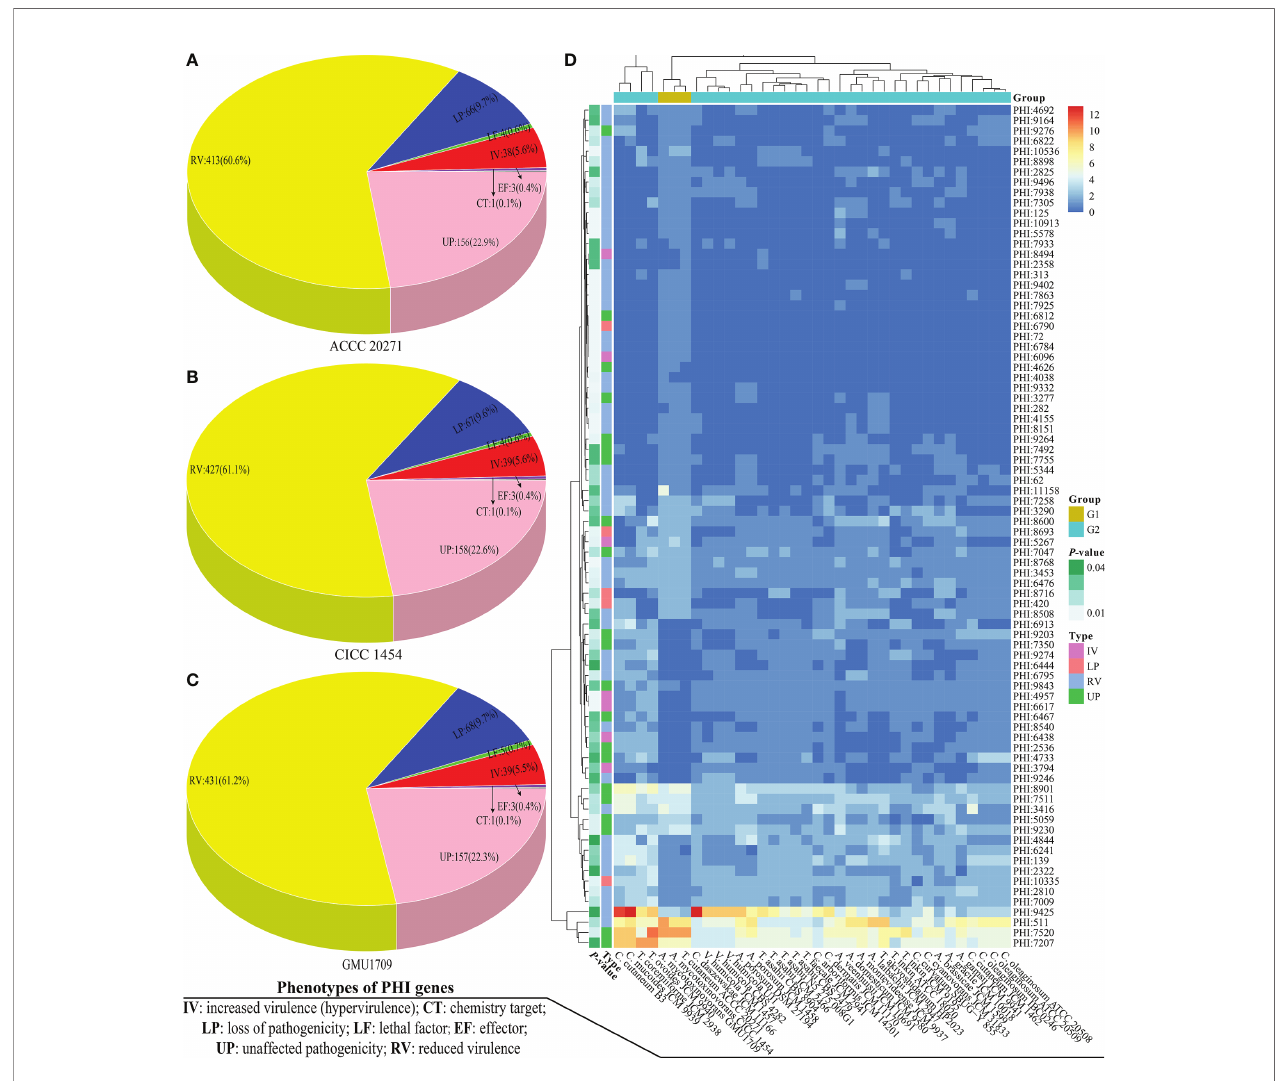
FIGURE 5 | Comparisons of pathogen-host interactions (PHI) annotation results. Number of genes corresponding to different PHI phenotypic terms in A. mycotoxinivorans ACCC 20271 (A) , CICC 1454 (B) , and GMU1709 (C) strains. (D) Differences (using the Wilcox test) in gene number of PHI-base accessions between A. mycotoxinivorans strains (G1 group) and other Trichosporonaceae strains (G2